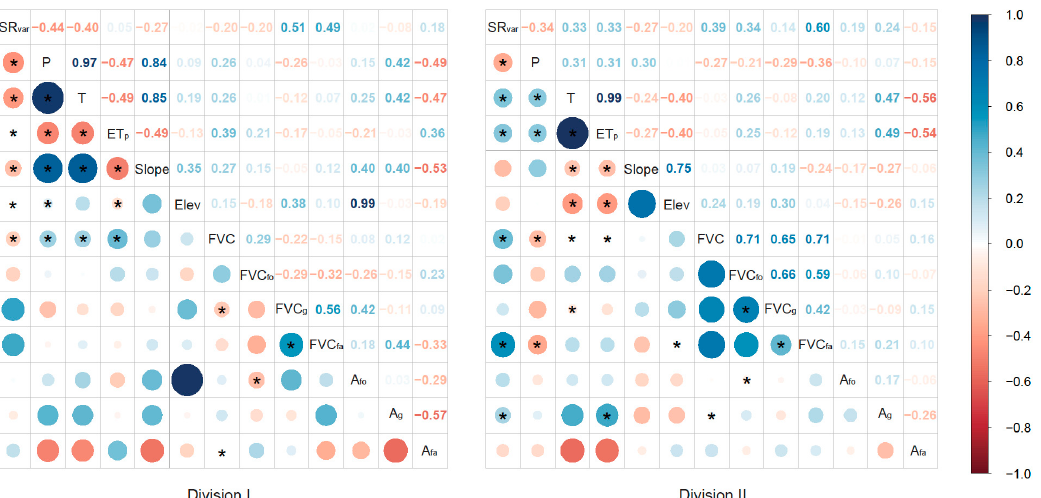
Figure 5. The correlation between the variation in wind erosion prevention services (WEPSs) and variation in various FVCs at the municipal scale. FVC: Fractional vegetation coverage; FVC Forest : Fractional vegetation coverage of forest; FVC Grass : Fractional vegetation coverage of grassland; FVC Farm : Fractional vegetation coverage of farmland.